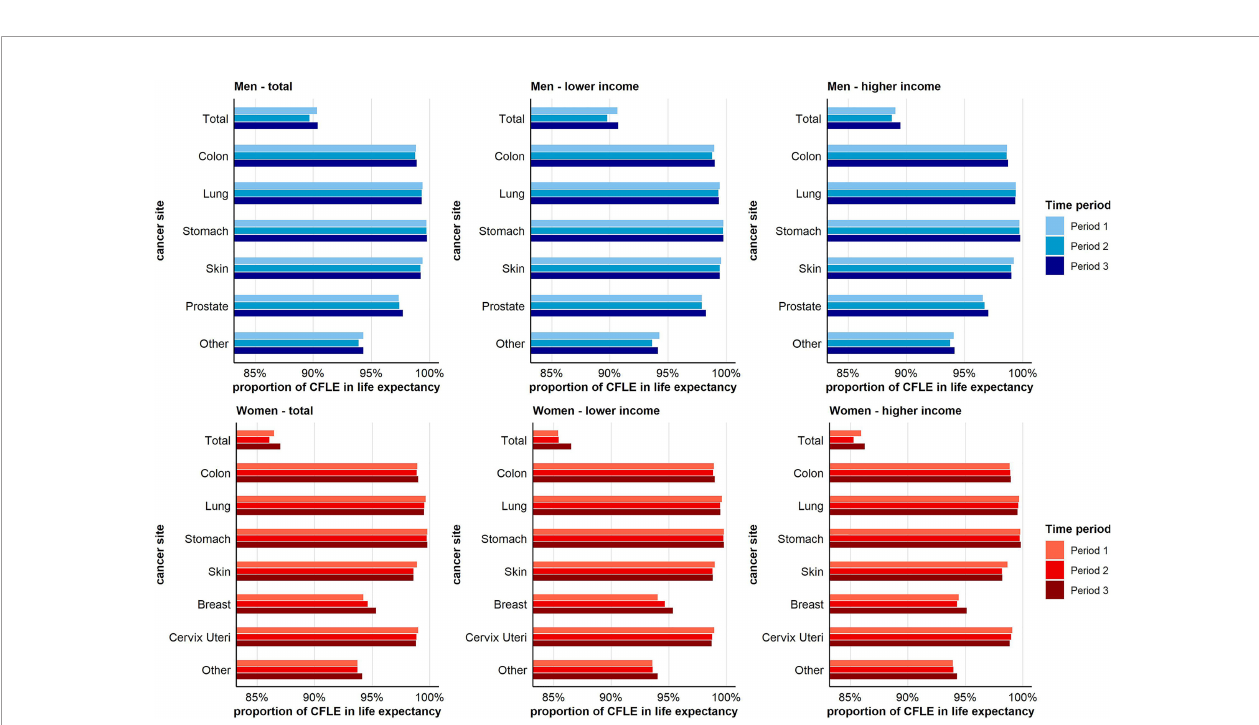
FIGURE 4 | Time trend in the proportion (in %) of cancer-free life expectancy in total life expectancy for total and site-speci fi c cancer by sex and income group at age 20.